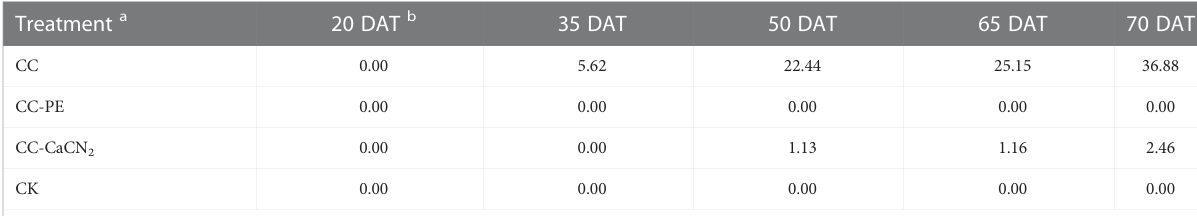
TABLE 5 Effects of different soil treatments on the disease index (DI) of cucumber Corynespora blight. Treatment a